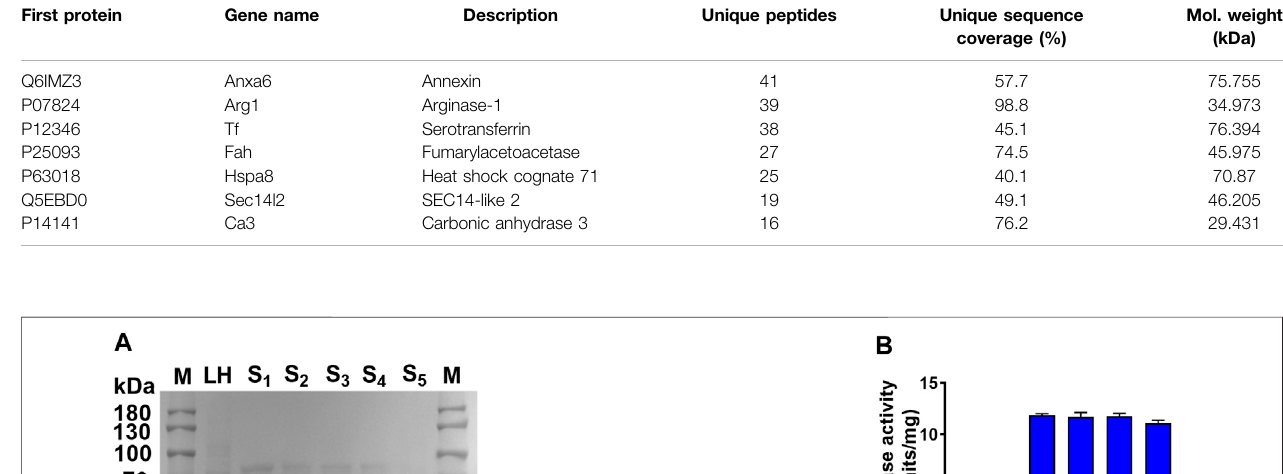
TABLE 1 | List of proteins detected in fi nally puri fi ed protein sample from rat liver using TripleTOF mass and TurboSEQUEST software.